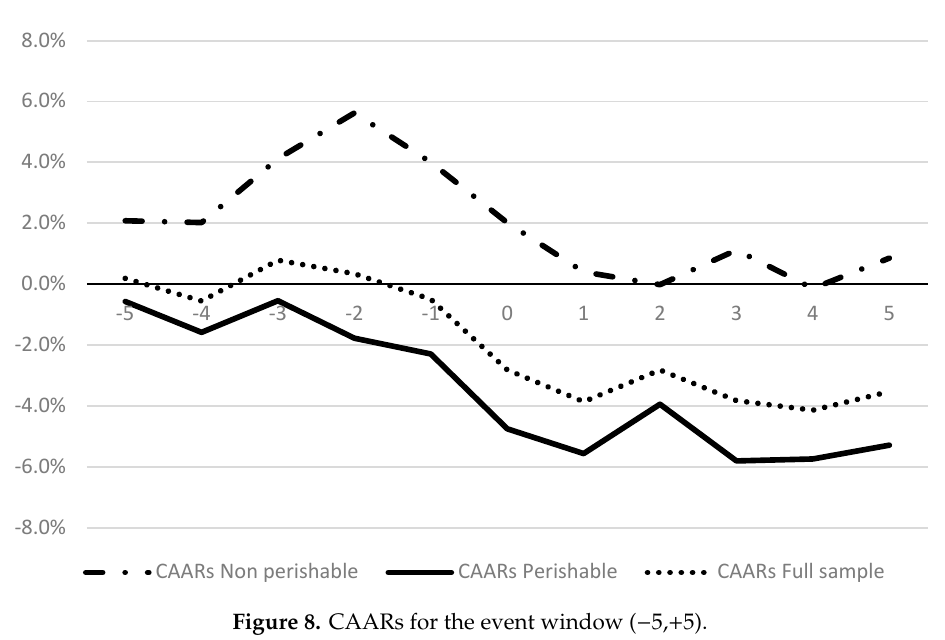
Figure 9. CAARs for the event window ( − 20,+20).